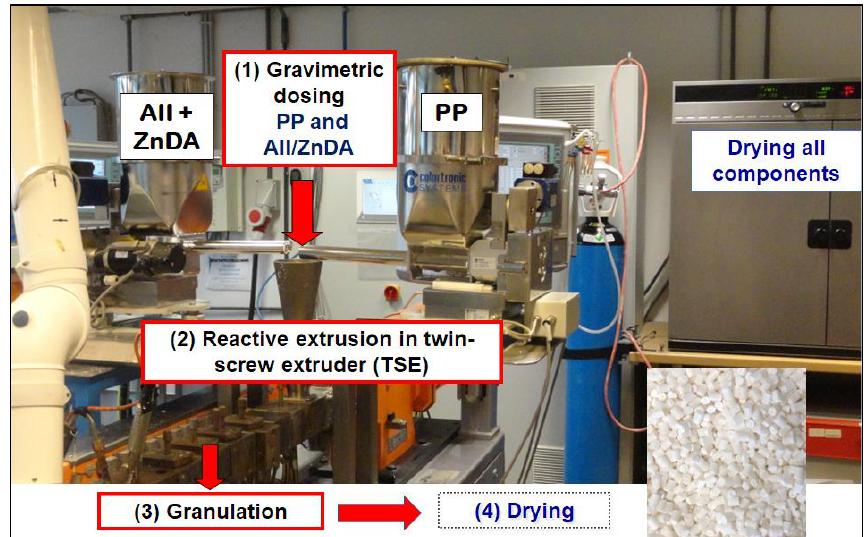
Figure 1. Experimental setup for the production by REx of modified PP – AII composites.